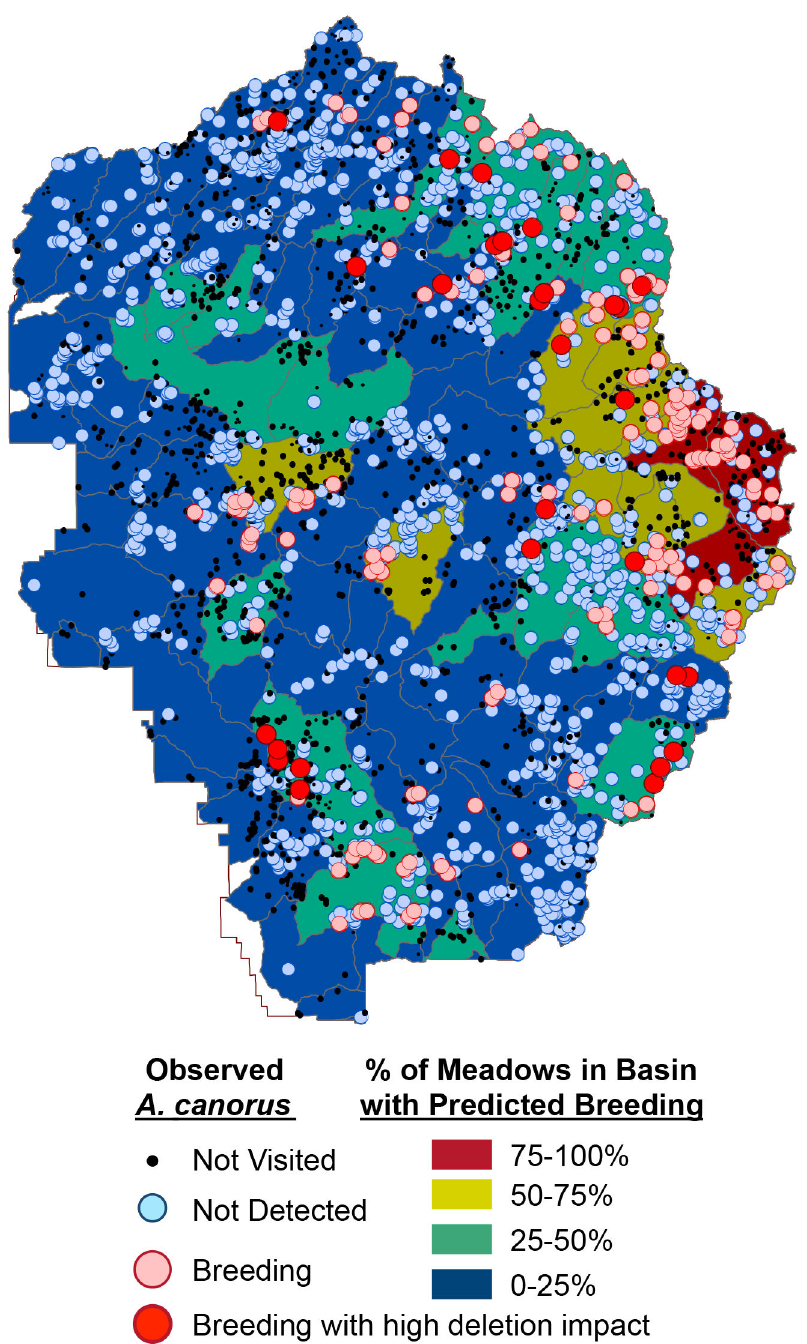
Figure 4. Observed and predicted distribution of meadows and watersheds with A. canorus breeding in Yosemite National Park. The watersheds (Cal 2.2.2 watershed planning units) are colored by the percent of meadows within the basin that are predicted by the Network Boosted GLM model to have breeding. The symbols are centroids for all 2,558 contiguous meadows in the park. Pink and/or red symbols indicate a meadow with observed A. canorus breeding at least once between 1992–2010. Blue symbols were visited at least once with no A. canorus detected. Small black dots are meadows that have not been visited. Solid read symbols are meadows with breeding that are in 90 th percentile of impact on park-wide breeding probability if deleted. Note that meadows with high deletion impact are not in the watersheds with highest proportion of ‘good’ meadows.